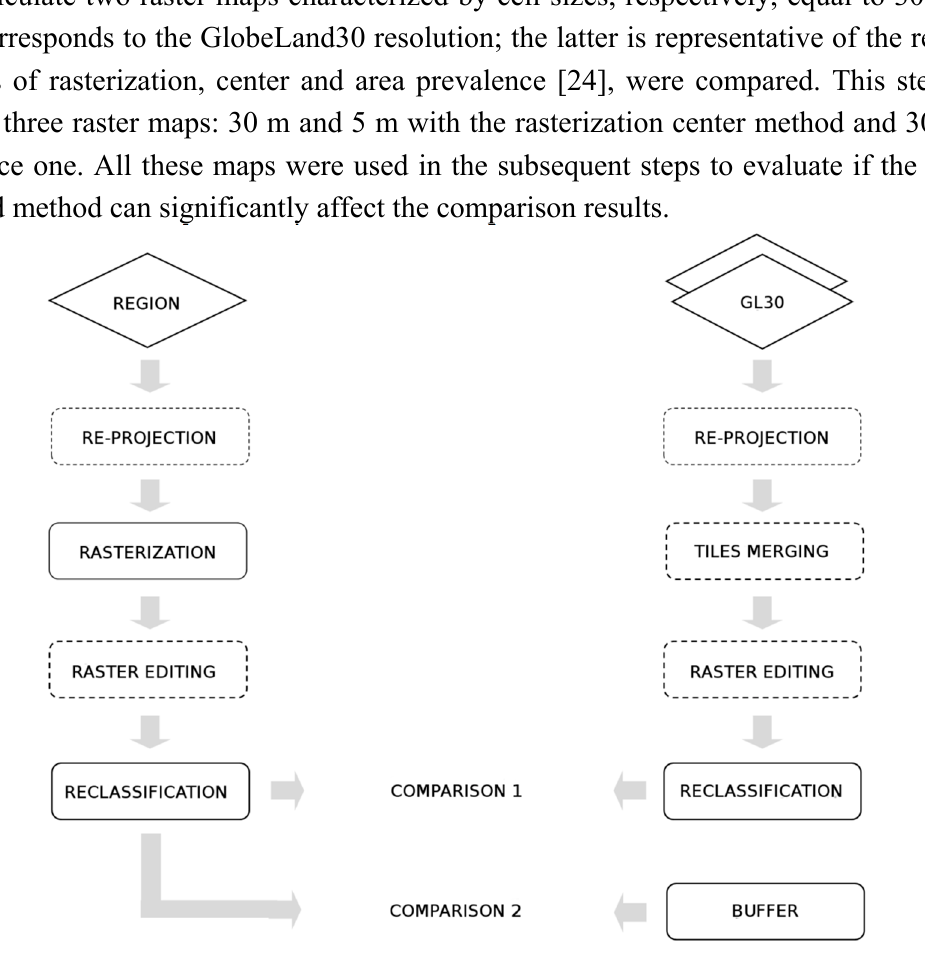
Figure 3. Data processing workflow performed on Italian datasets and GlobeLand30 (GL30). Dashed boxes represent additional steps required for only some